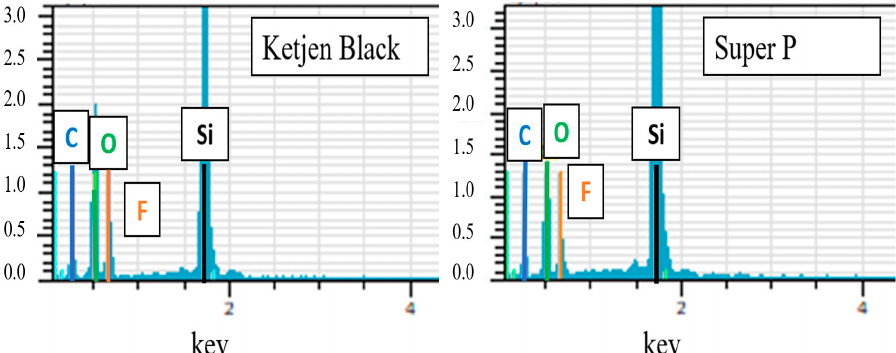
Figure 7. The SEM images of pyrolytic silicon-based anodes after the first discharge–charge cycle. Images ( C,D ) are enlarged images of ( A,B ), respectively. Images ( A,C ) are anodes with the KB ad- ditive. Images ( B,D ) are anodes with the Super P additive.